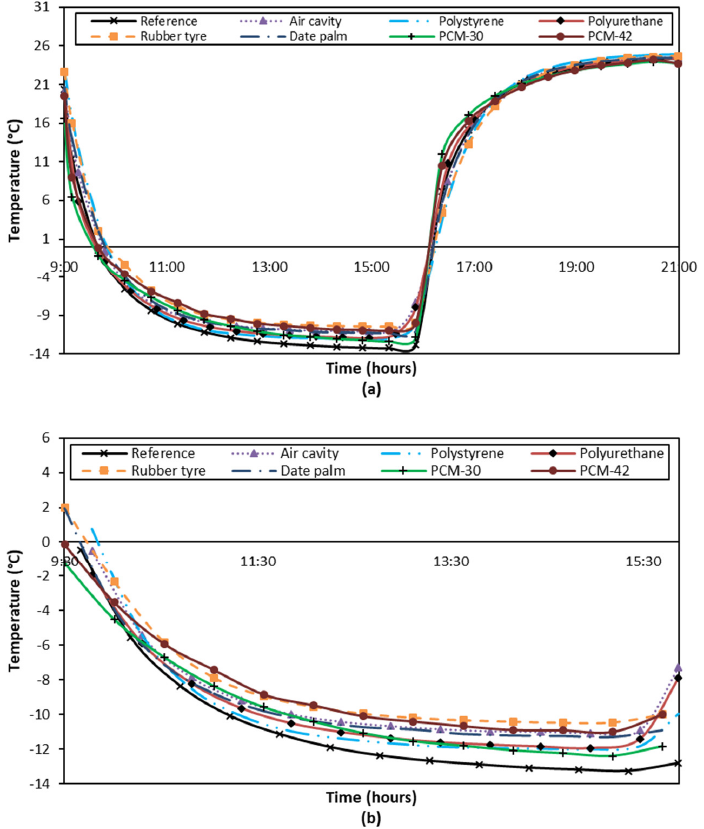
Figure 5. Thermal performance curves for front surface, ( a ) from start to end and ( b ) at the steady state. Performance of the insulation materials was significant at the back surface of the samples as shown in Figure 6. Reference geopolymer concrete cube attained its steady state at 8.3 °C which is 4.1 °C lower than the least performing insulation material (i.e., air). Expanded polystyrene foam performed excellent among all materials and reached to the steady state temperature at the back surface at 17.2 °C. Insulation effect of almost same level was achieved using rubber tire which attained its steady state at 16.9 °C. Similarly, polyurethane foam, PCM-30 and PCM-42 increased the back surface steady state temperatures by the values of 5.8, 5.5 and 4.8 °C compared to the reference respectively. In a similar study, Šimko et al. proposed insulation panels embedded with water circulation pipes for existing and new construction for dual functions of the configuration (space heating and thermal barrier to reduce heat flow outside from indoor). During the operation phase of space heating, the proposed design reduced heat capacity by 50% compared to the system when pipes are embedded in concrete rather than insulation and reduced the heat capacity by 63% compared to the design when pipes are arranged under the surface [26].